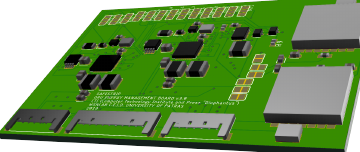
Figure 11. A 3D model of the PCB we designed for our proposed